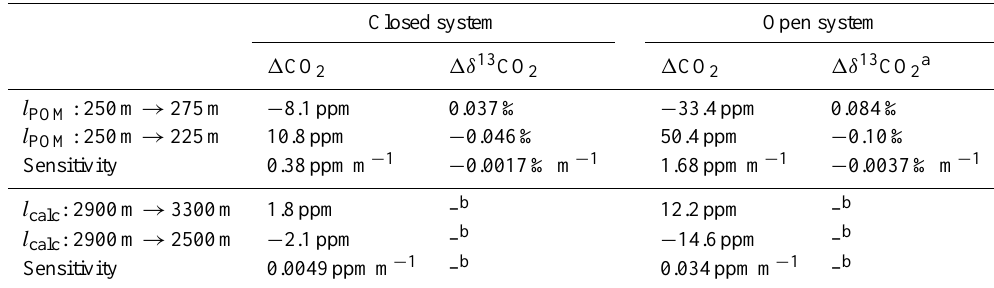
Table 3. Equilibrium changes in atmospheric CO 2 and 13 CO 2 (expressed as δ 13 C) induced by a global change in the mean remineralisation depth of POM and the calcite redissolution length scale.